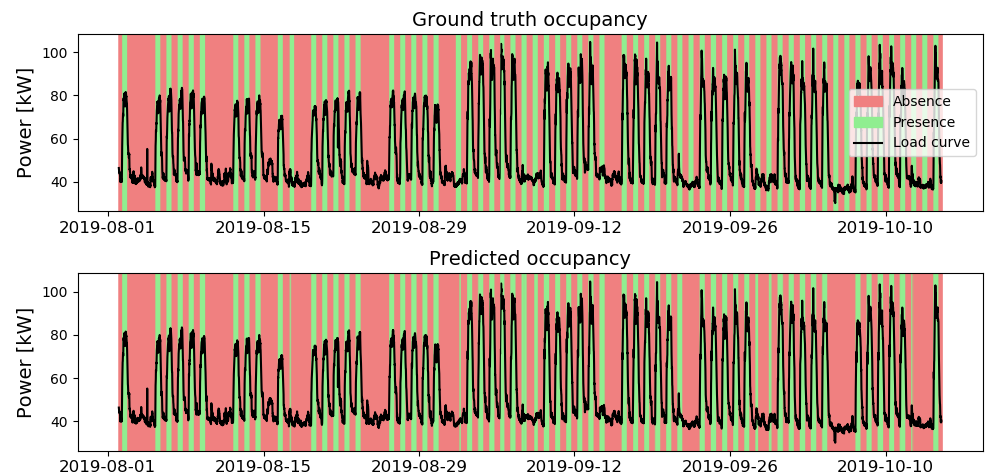
Figure 4. Results of supervised Occupancy Forecasting app on selected part of test dataset.